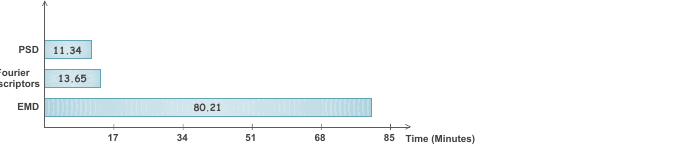
Figure 10. Classification time of three feature sets using proposed technique in seconds.